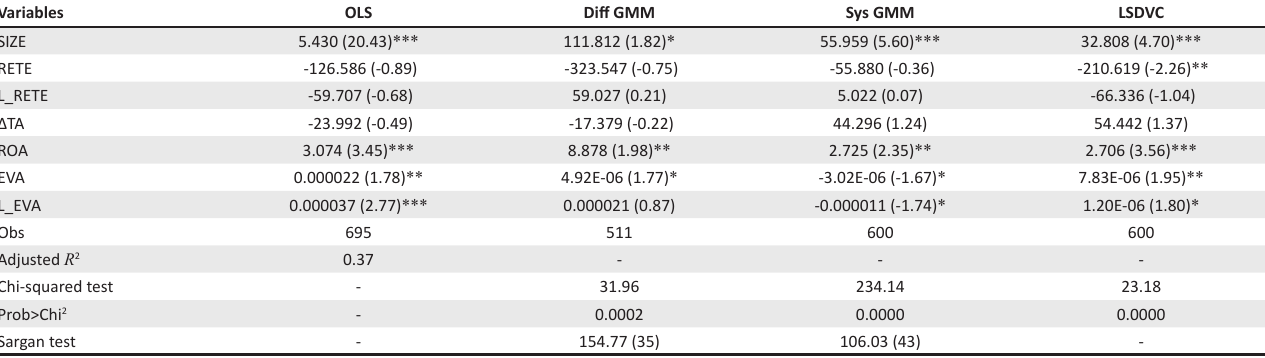
TABLE 3: Regression results for the test of dividend life-cycle hypothesis and determining factors: Panel 2. Variables